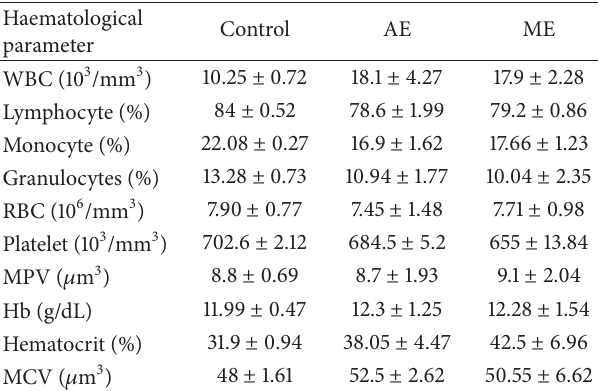
Table 2: Mean relative organ weights of mice ingested with 2000 mg/kg aqueous and methanolic seed extracts of A. esculentus . Each value is expressed as organ-to-body weight % ratio.